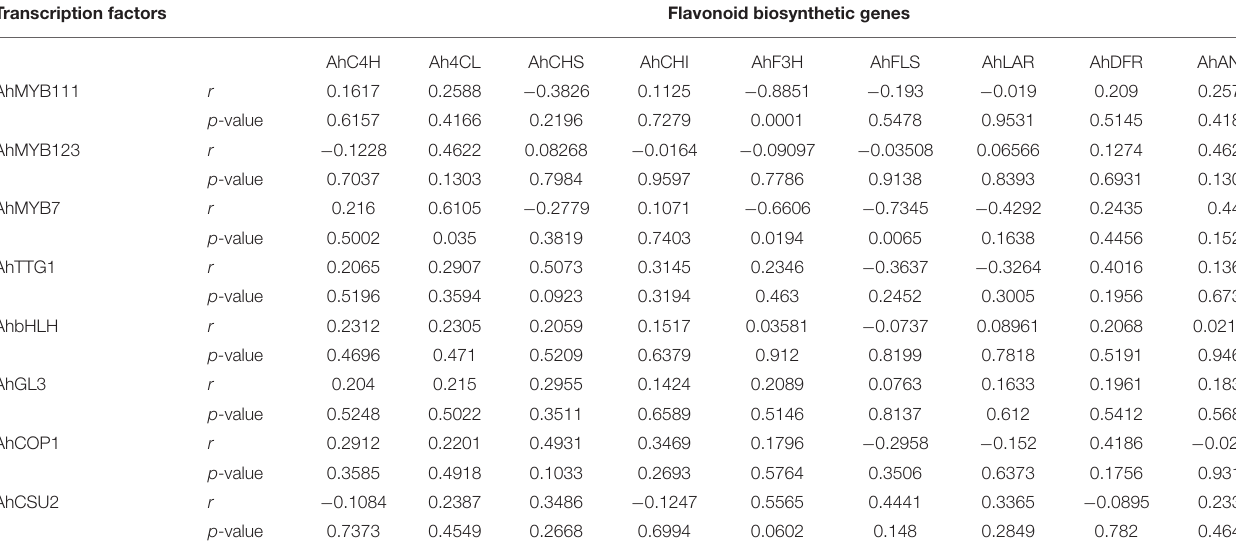
TABLE 2 | Correlational analysis between the expression of flavonoid biosynthetic pathway genes and transcription factors (TFs) in peanuts under water deficit conditions. Transcription